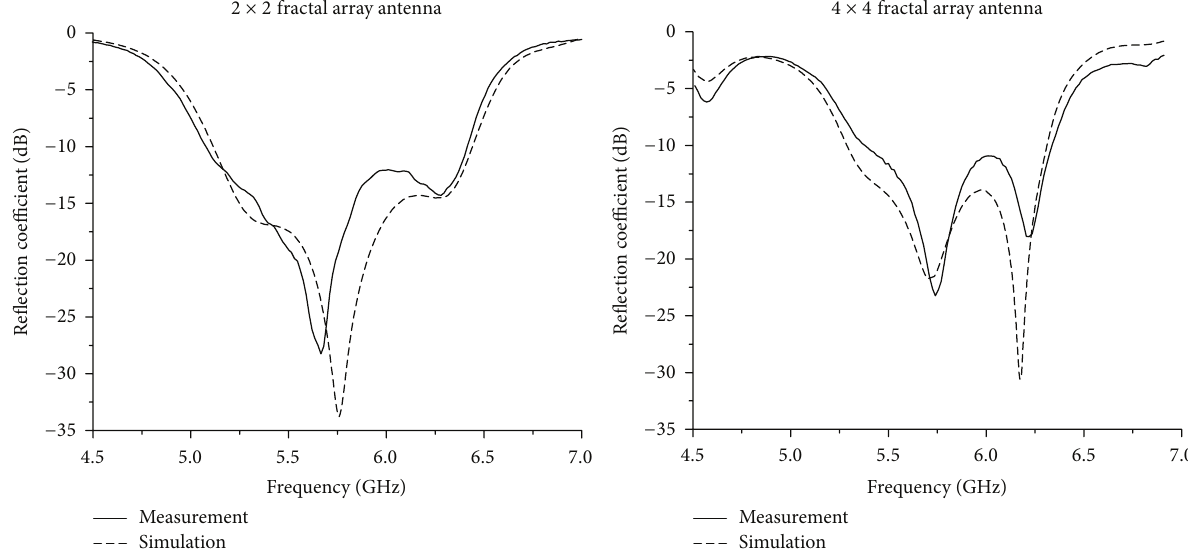
Figure 14: The measured and simulated reflection coefficients of the prototype